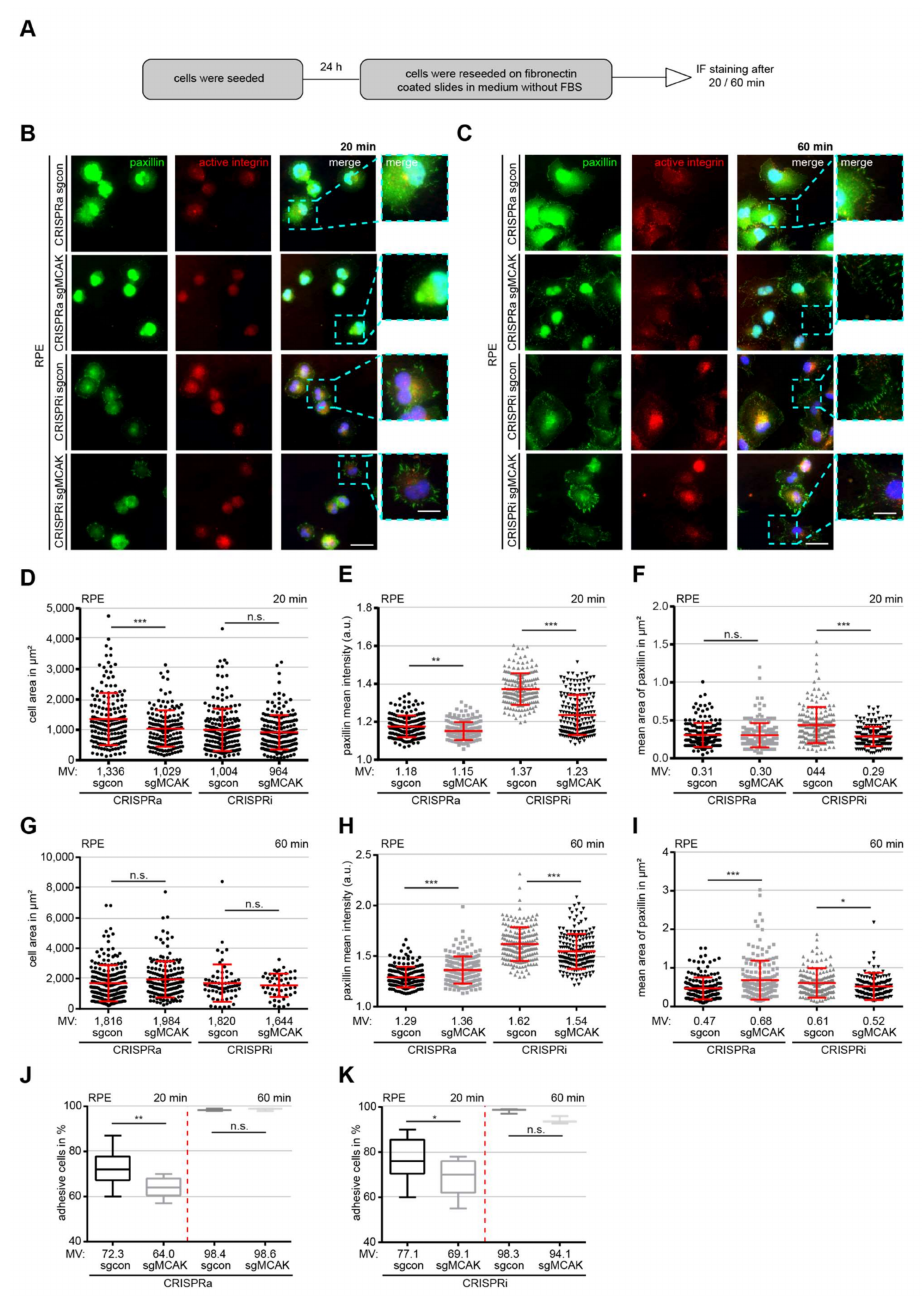
Figure 4. Deregulation of MCAK impairs the cell spreading and adhesion capacity . ( A ) Schedule of cell spreading/adhesion assay. ( B , C ) RPE CRISPRi/a cells were stained for active integrin (red), paxillin (green), and DNA (DAPI, blue). Repre- sentatives of 20 min and 60 min cell re-adhesion are shown. Scale: 25 µ m; inset scale: 10 µ m. ( D , G ) Quantification of cell size of RPE CRISPRi/a sgcon and sgMCAK cells at 20 min ( D ) and 60 min ( G ) after reseeding. The results are based on three independent experiments and presented as scatter plots showing mean ± SEM (180 cells). ( E , H ) Quantification of the mean fluorescence intensity of paxillin after 20 min ( E ) and 60 min ( H ) after reseeding (180 FAs measured in each experiment). The results are based on three independent experiments and presented as scatter plots showing mean ± SEM. ( F , I ) Measurement of the paxillin signal size after the cells were reseeded for 20 min ( F ) and 60 min ( I ) (at least 60 FAs measured in each experiment). The results are based on three independent experiments and presented as scatter plots showing mean ± SEM. ( J , K ) Quantified percentage of fully re-attached cells after 20 min ( J ) and 60 min ( K ) (50 cells measured in each experiment). The results are based on three independent experiments and presented as box plots showing mean ± SEM. Unpaired Mann–Whitney U test for ( D – I ). Student’s t -test for ( J , K ). * p < 0.05, ** p < 0.01, and *** p < 0.001. Abbreviation: n.s.: not